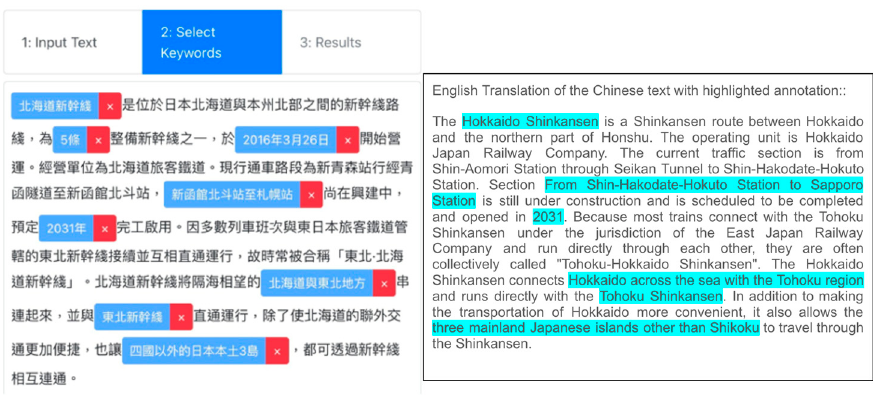
Figure 5. Step 2: the pre-selected phrase is replaced by the user annotation.